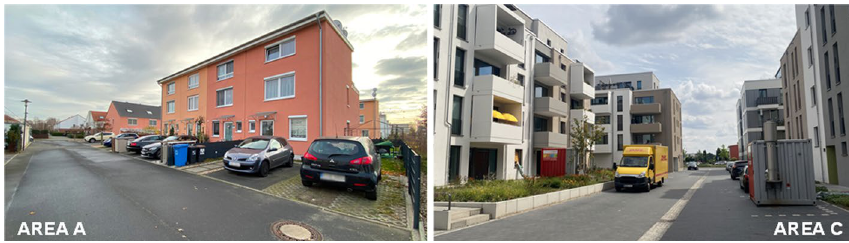
Fig. 2 Pictures of residential buildings in study areas A and C (photographed by Heldt in 2021)